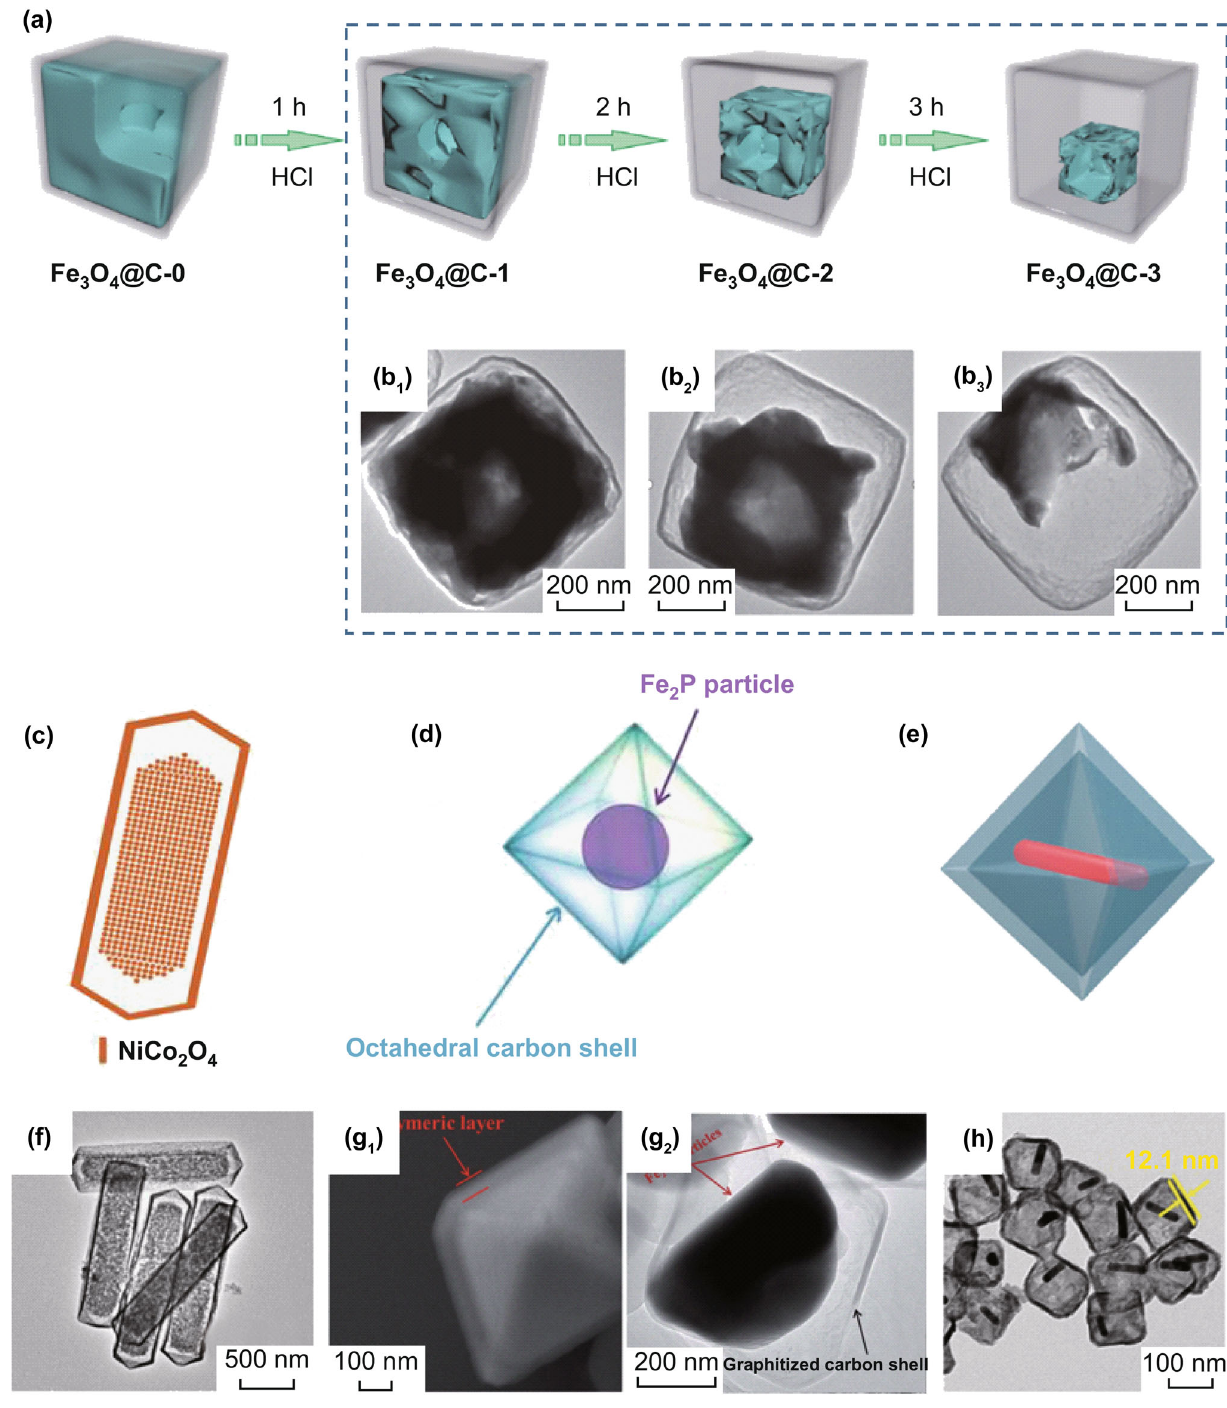
Fig. 3 a Schematic illustration YS Fe 3 O 4 @C nanobox following 1-, 2- and 3-h etching time. The TEM images ( b 1 , b 2 , b 3 ) of Fe 3 O 4 @C nanobox are shown in the dashed box corresponding to 1-, 2- and 3-h etching, respectively. Reprinted with permission from Ref. [84]. Graphical illustrations of c YS nanoprism of Ni–Co mixed oxide, d YS octahedral Fe 2 P@C, and e YS octahedral Au nanorod@Cu 7 S 4 . f TEM image of YS Ni–Co mixed oxide nanoprism.